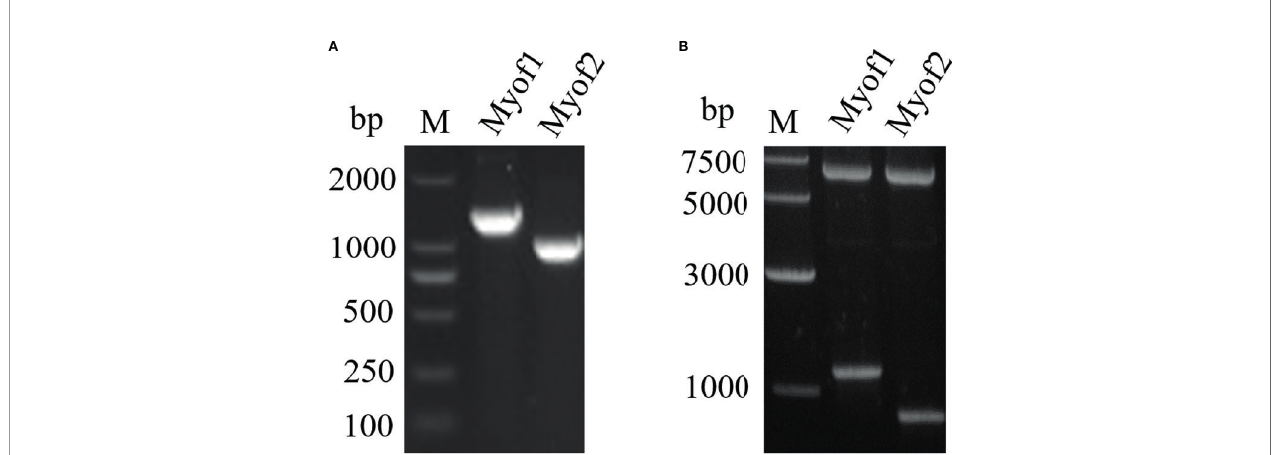
FIGURE 5 | Ampli fi cation and cloning of Myof1 and Myof2. (A) The ampli fi ed genes of Myof1 and Myof2 (1500 bp and 810 bp) using speci fi c oligonucleotide primers. (B) Cloning of the coding sequence for Myof1 and Myof2 into the pET32a vector; the inserted DNA was digested with Bam HI and Xho